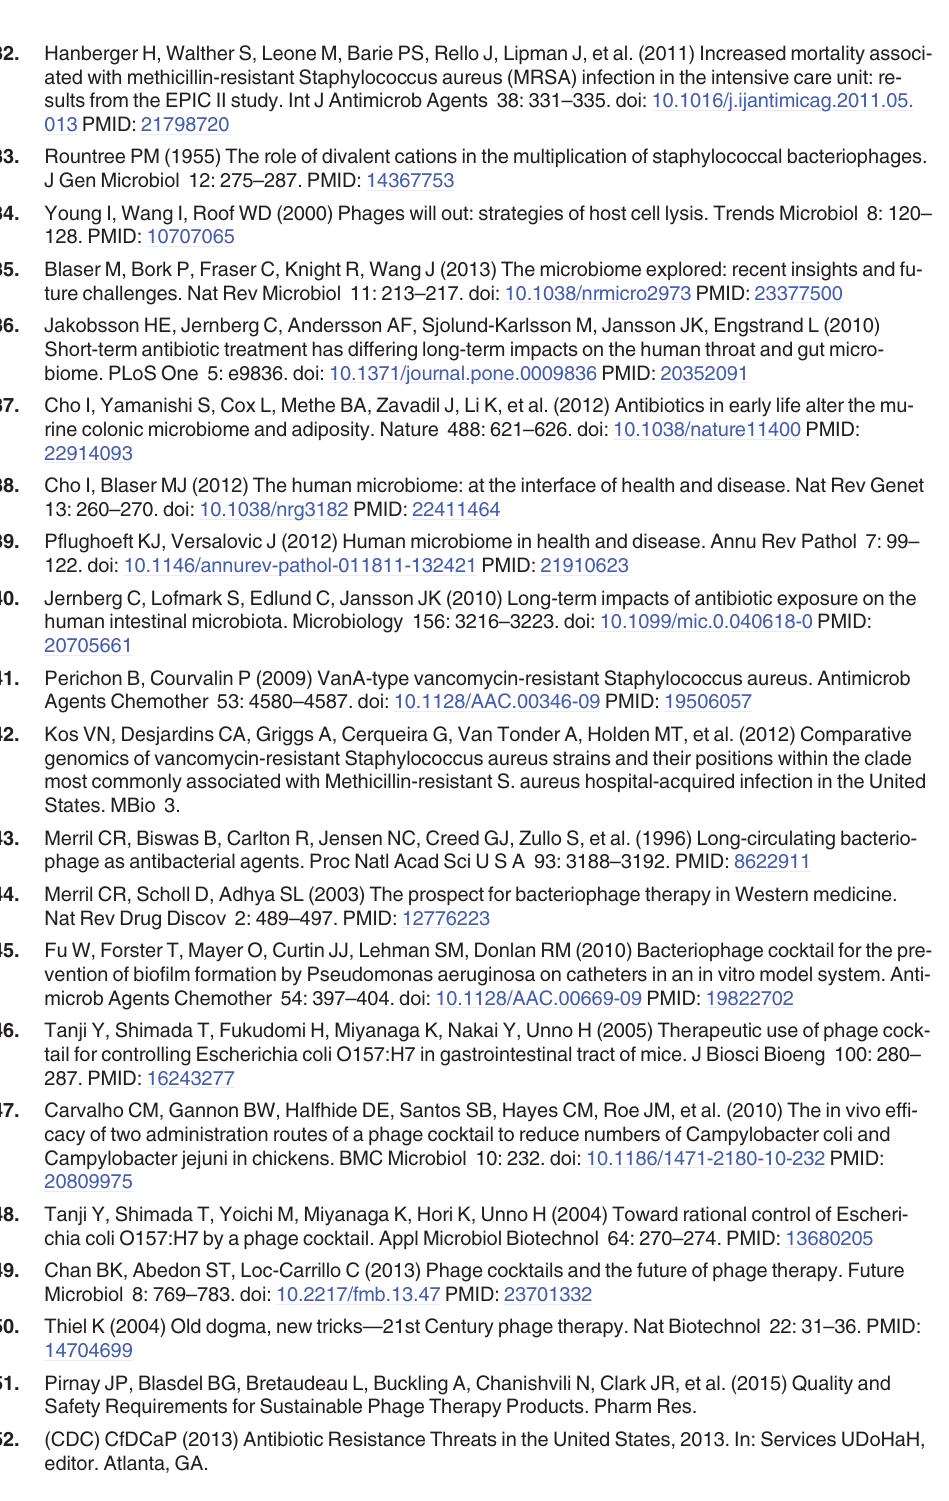
PLOS ONE | DOI:10.1371/journal.pone.0124280 April 24,